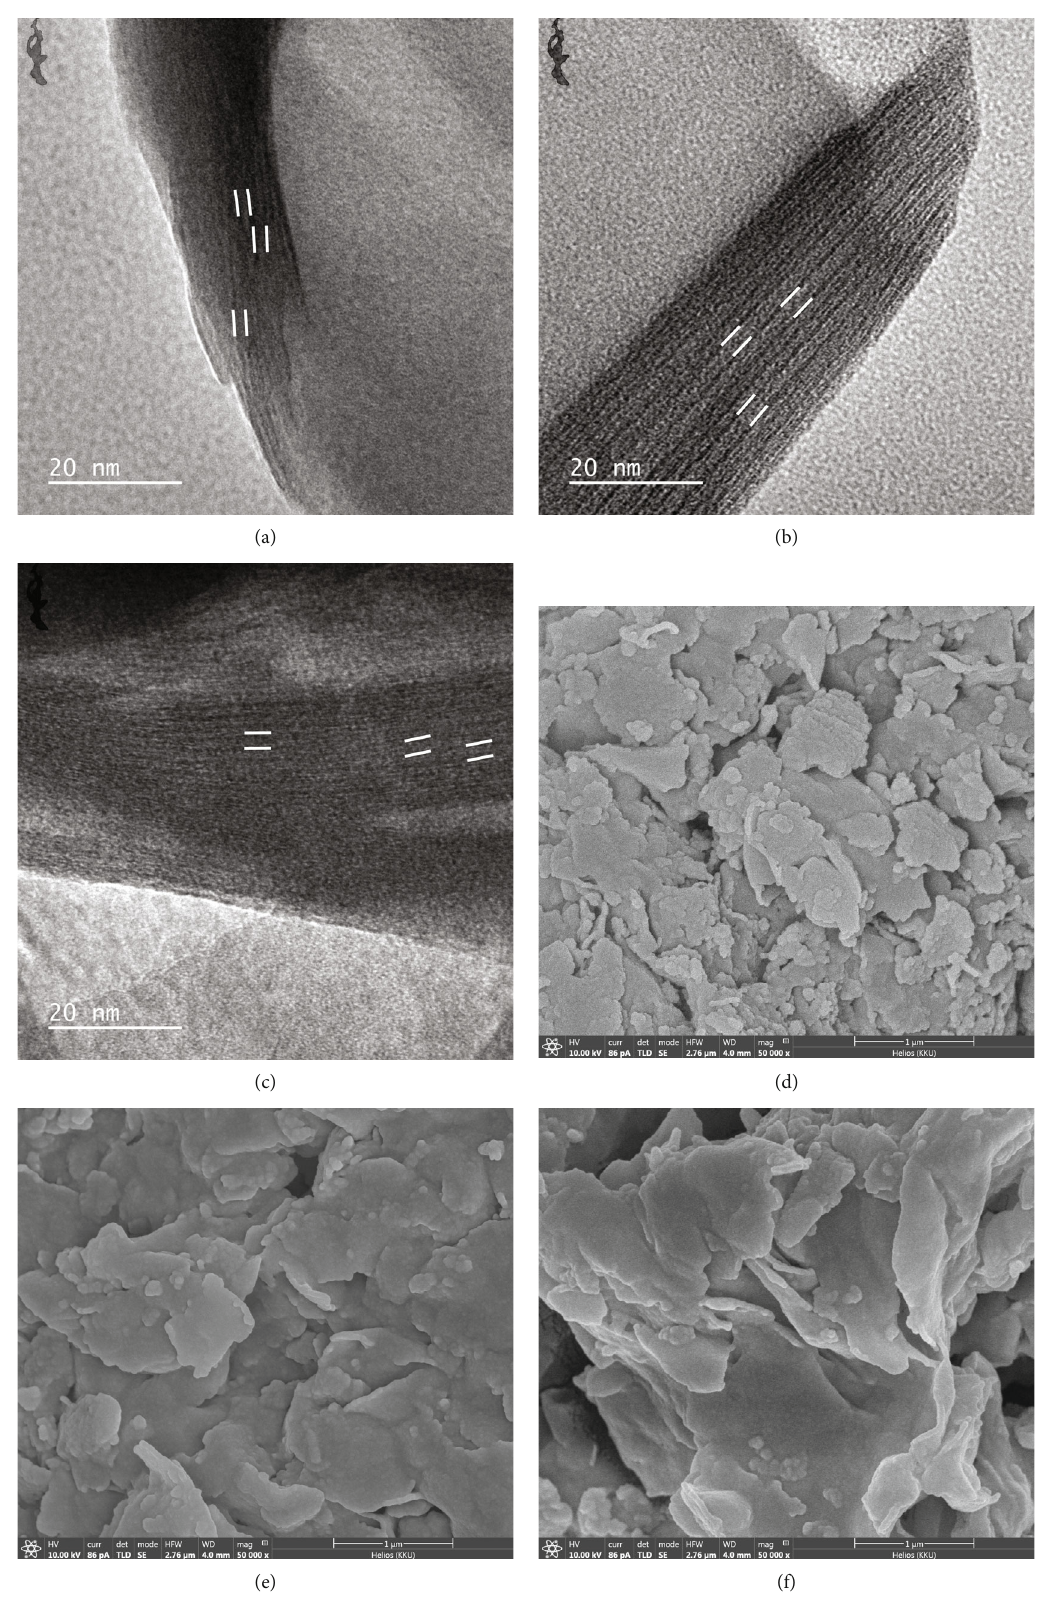
Figure 7: TEM images of (a) NTB, (b) 1CPC, and (c) 1HDTMA ( scale bar = 20 nm ). (d) – (f) FESEM microphotographs of NTB, 1CPC, and 1HDTMA, respectively (50,000x magni fi